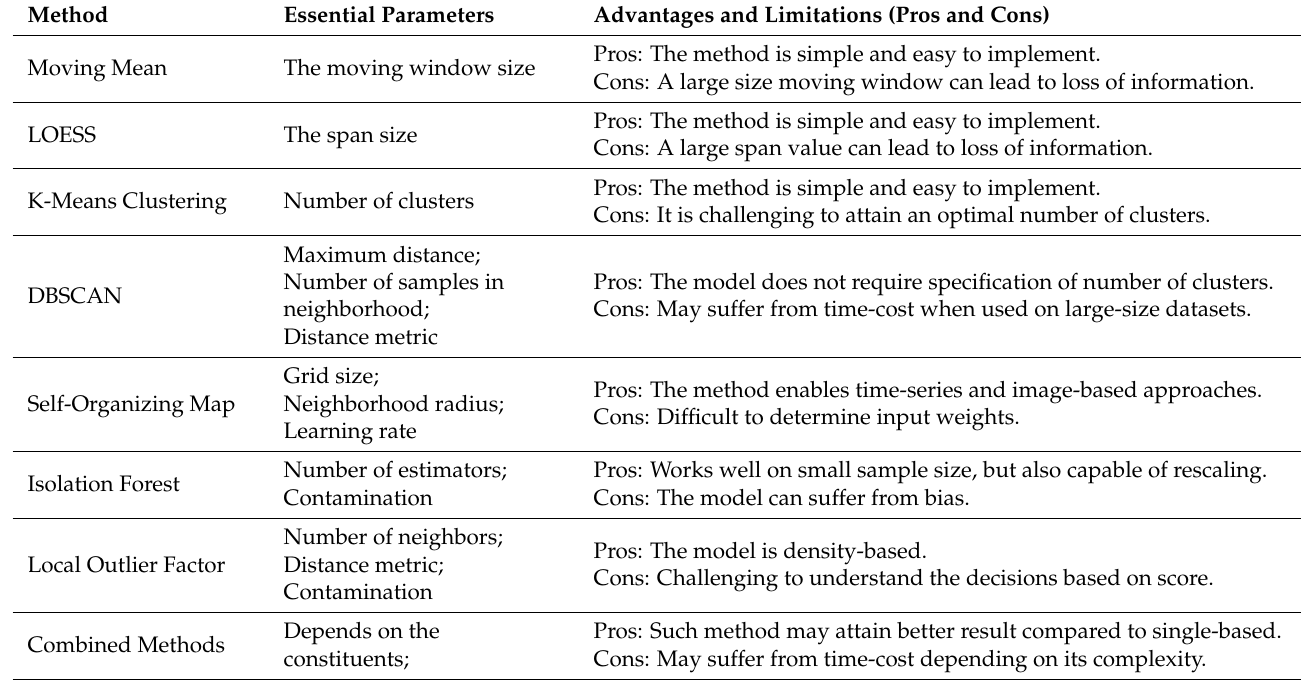
Table 4. Advantages and limitations (data preprocessing methods).